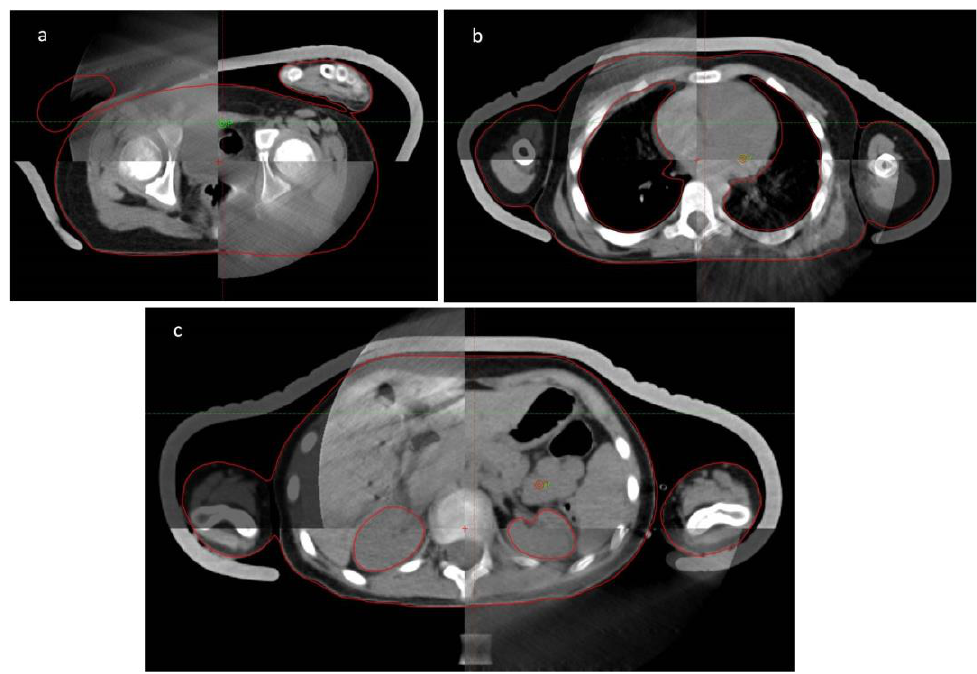
Figure 2. Image guided kilovolt cone-beam CT controls: ( a ) at the isocenter level ( b ) at lung area, ( c ) at kidney area.